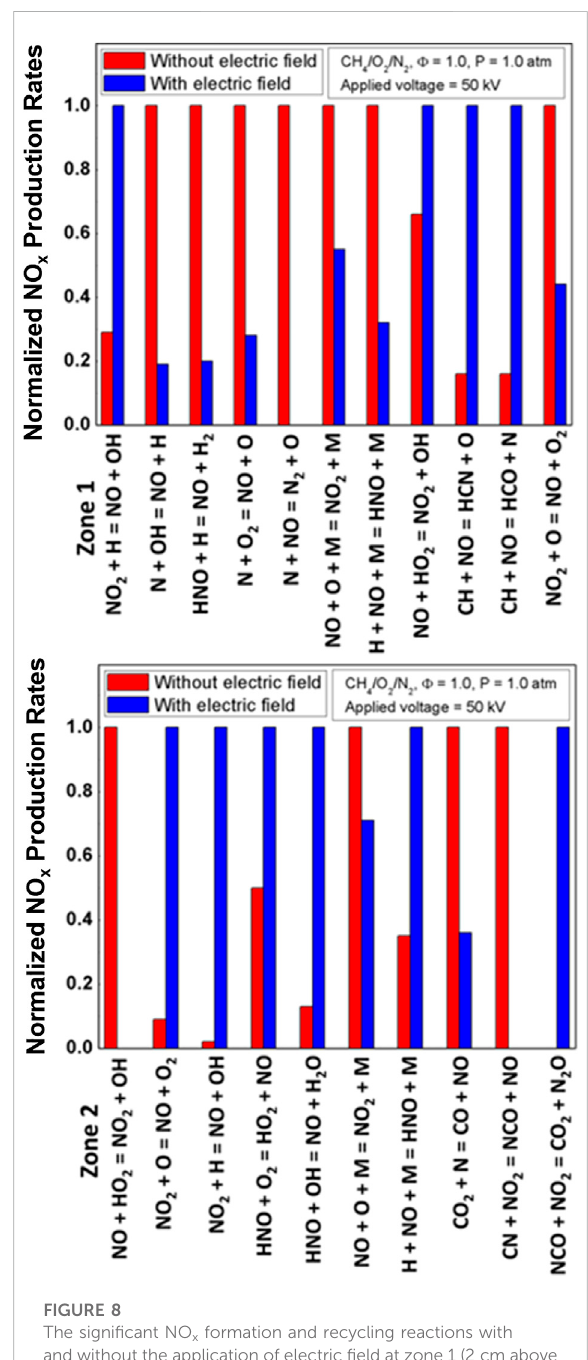
The signi fi cant NO x formation and recycling reactions with and without the application of electric fi eld at zone 1 (2 cm above the burner) and zone 2 (40 cm above the burner) for stoichiometric ( Φ = 1.0) case at a fl ow rate of 3.45